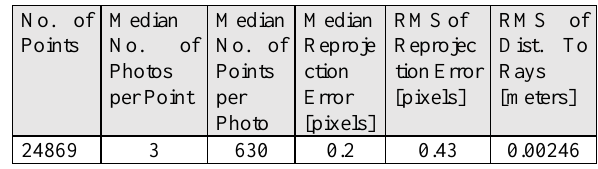
Table 2: Generated tie points Tie point uncertainties derived from the position vagueness.